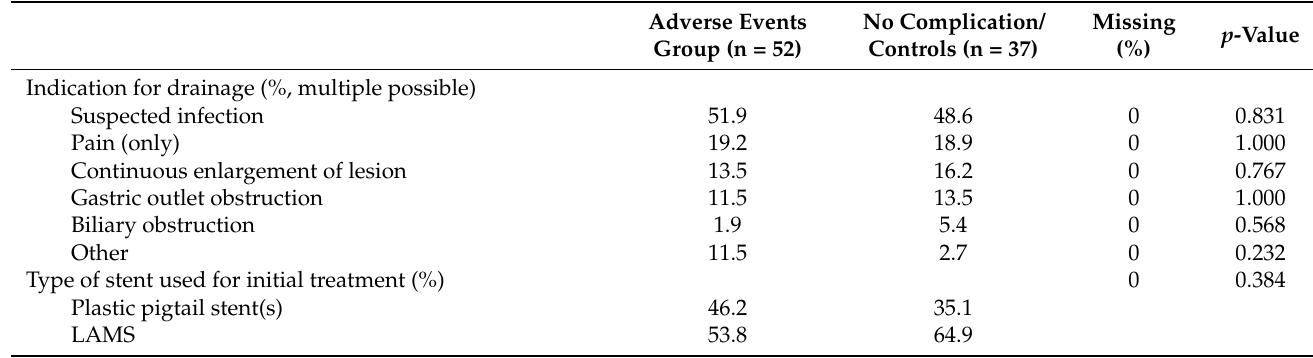
Figure 2. Treatment characteristics of adverse events cases. Shown are the odds ratios (95% confidence interval) for the occurrence of any adverse event ( top ) and the rates of positive necrosis cultures ( A ) or the mean lesion maximum diameter ( B ) in cases with the respective adverse event ( bottom ). * Indicates a significant ( p < 0.05) difference compared to the controls. Table 2. Treatment characteristics of cases with adverse events and uncomplicated